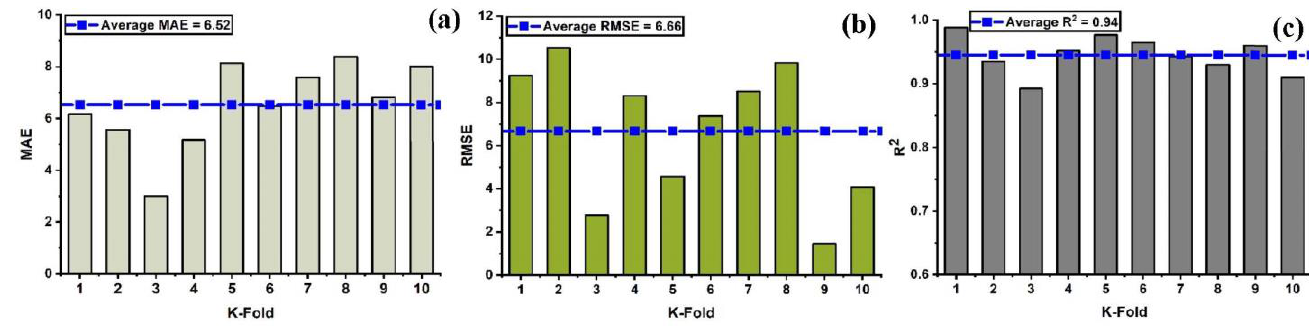
Figure 11. Cross-validation; ( a ) RF with MAE; ( b ) RF with RMSE; ( c ) RF with R 2 . Table 5. Cross-validation results of the SVM model with ensemble algorithms.